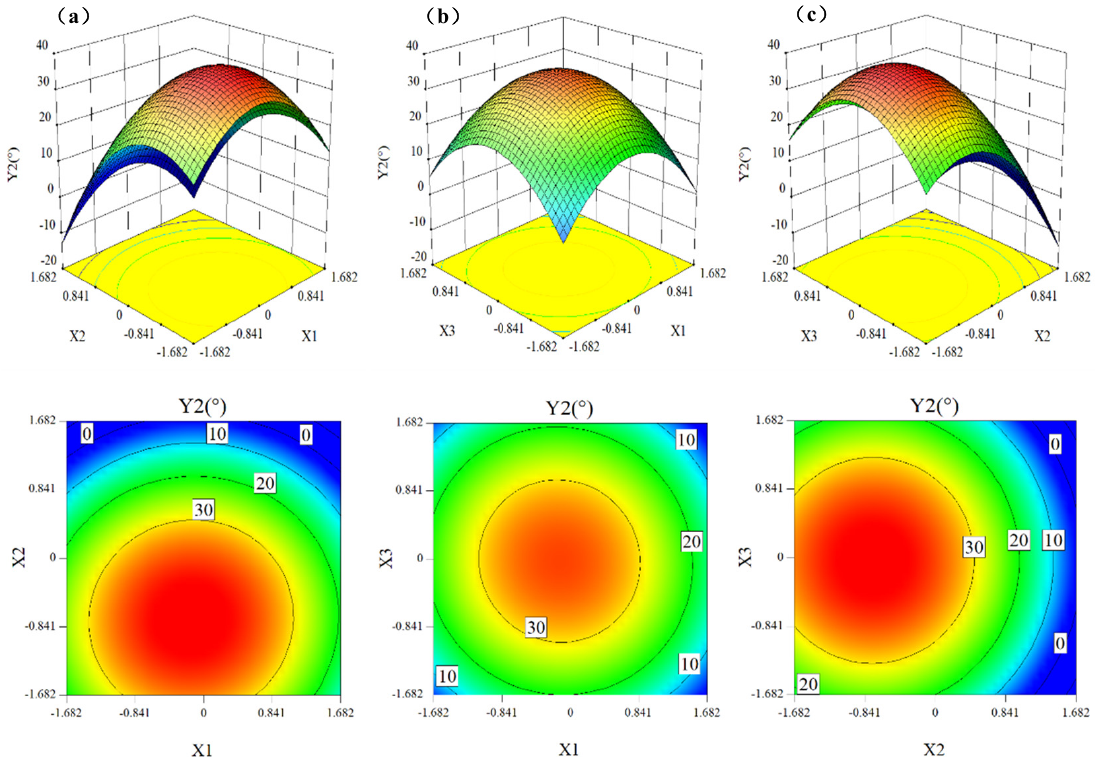
Figure 4. Interactive effects of ( a ) clay content and moisture content; ( b ) clay content and soil wet bulk density; ( c ) moisture content and soil wet bulk density on internal friction angle.